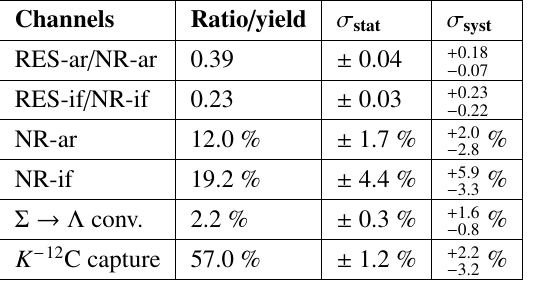
Table 1. Resonant to non-resonant ratios and amplitudes of the various channels extracted from the fit of the Λ π − sample. The statistical and systematic errors are also shown. See text for details.